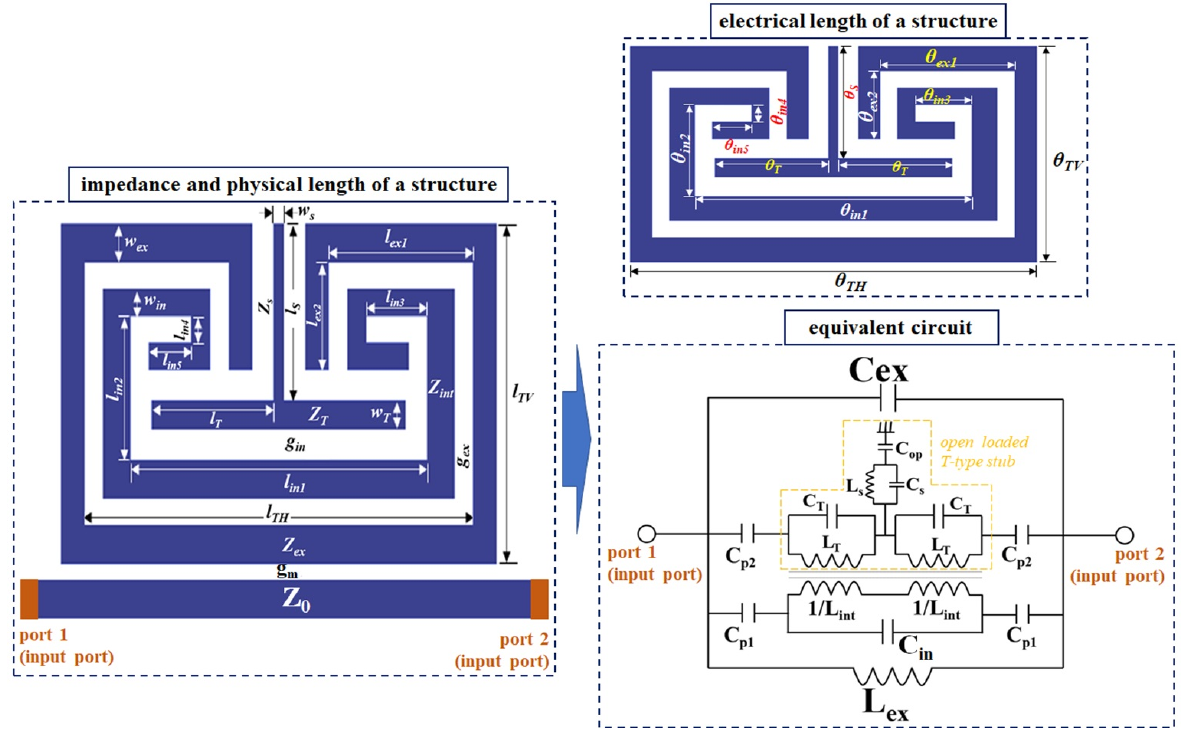
Figure 2. Proposed resonator.